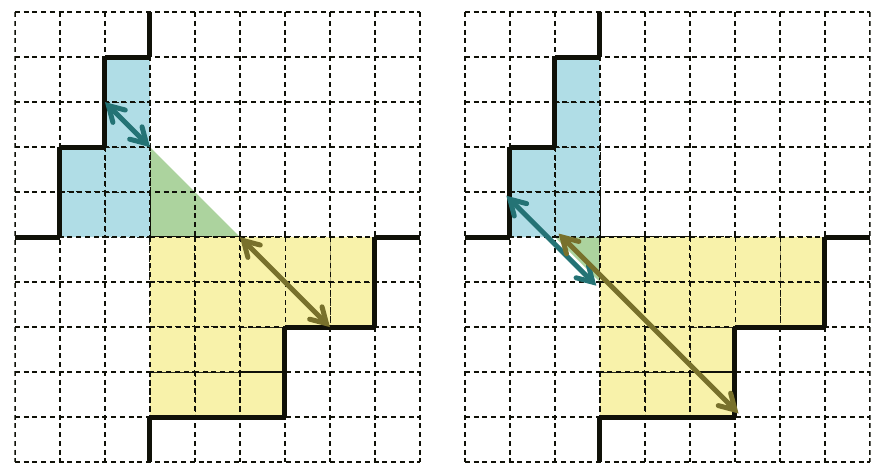
Figure 2 . A pictorial interpretation of R and R for M being positive or negative. R and R are respectively given by the length of the dark yellow arrow and that of the dark cyan arrow. For